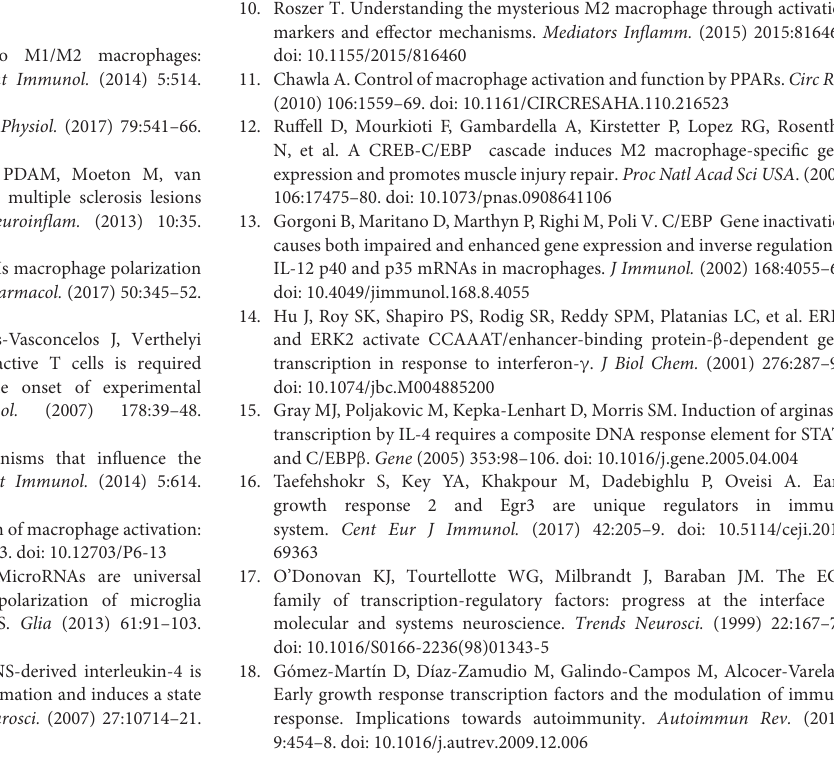
Figure S7 | Analysis of the expression of the CEBP β protein in M2/M(IL-4) and M1/M(FN γ /LPS) macrophages. Bone-marrow-derived macrophages (BMDMs) were used as unstimulated (M0) or stimulated with IFN γ and LPS (M1), or IL-4 (M2) for 24h as for Figure 12E and the level of expression of CEBP β was analyzed by western blot as described in Materials and Methods . Representative whole blots for CEBP β and β -Actin are shown. Figure S8 | Model of regulation of macrophages plasticity by Egr2. Unstimulated M0 macrophages express Egr2 and do not express M1 and M2 markers such as NOS2 and Agr1 exhibiting Egr2 + NOS2 − Arg1 − phenotype. After stimulation with IFN γ and/or LPS macrophages downregulate Egr2 and become M1 with Egr2 − NOS2 + Arg1 − phenotype. Further stimulation of M1 macrophages with IL-4 or IFN γ /LPS result in deactivated (M-dea) Egr2 − IL-10 + phenotype with a low level of M1 and M2 markers. On the other hand, M0 macrophages stimulated with IL-4 toward M2 become Egr2 +++ NOS2 − Arg1 + . Further stimulation of M2 macrophages with IFN γ /LPS result in M1 phenotype with upregulation of M1 and downregulation of M2 markers. Figure S9 | In silico analysis of Cebpb gene promoter area for the presence of Egr2-binding sites, and the analysis of Egr2 promoter area for the presence of CEBP β - and Nrf1- binding sites. (A) Mapping of 3,000 bp promoter region upstream of mouse Cebpb gene (chromosome 2) using MULAN software (https:// mulan.dcode.org/). Egr-binding sites upstream of Cebpb gene are shown by red boxes. (B) Mapping of 3,000 bp promoter region upstream of mouse Egr2 gene (chromosome 10) using MULAN software (https://mulan.dcode.org/). CEBP β - and Nrf1- binding sites upstream of Egr2 are shown by yellow and green boxes,